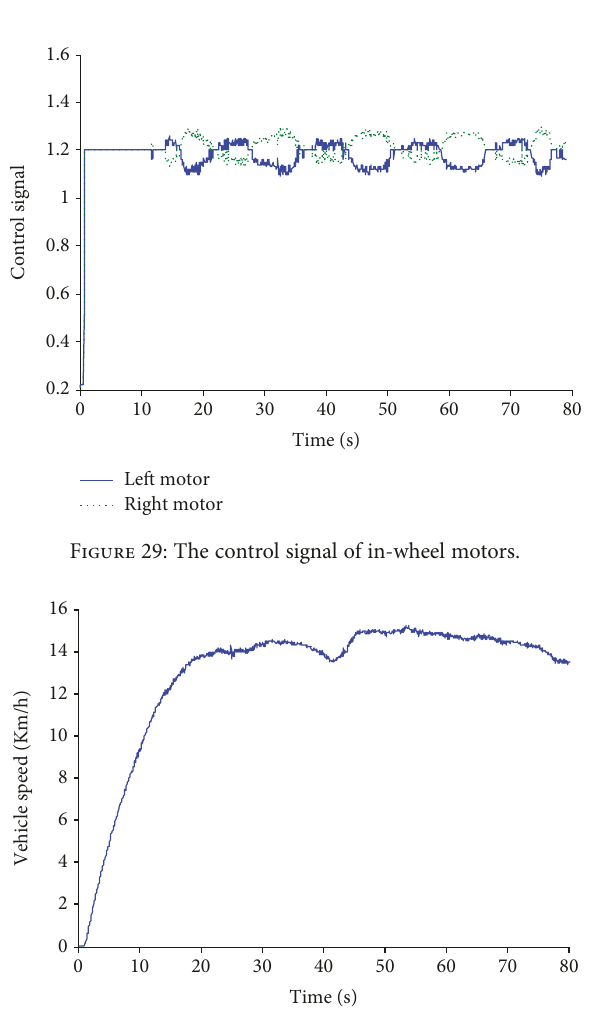
Figure 30: Vehicle speed of road test.